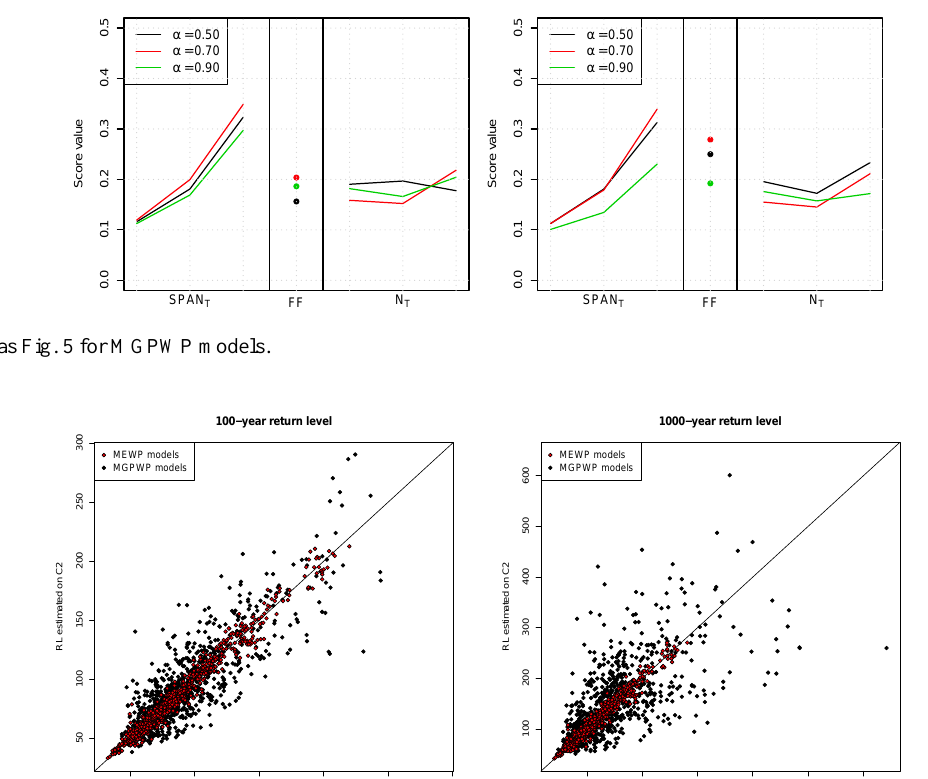
Figure 7. Comparison of the 100-year and 1000-year return levels (inmm) estimated on C ( 1 ) and C ( 2 ) , for the four MEWP models (in red) and the four MGPWP models (in black), with a level α = 0 . 5 (one point per